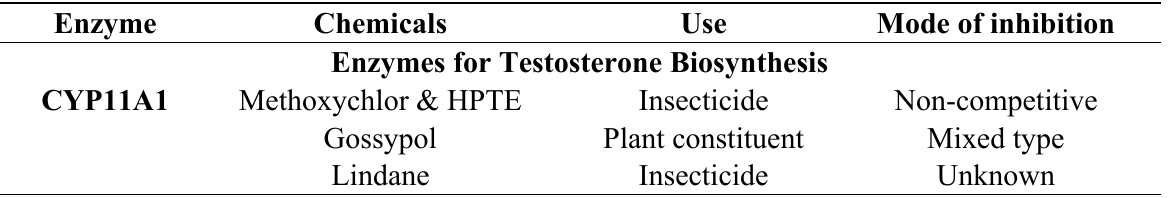
Table 1. Inhibitors of enzymes for testosterone biosynthesis and metabolic